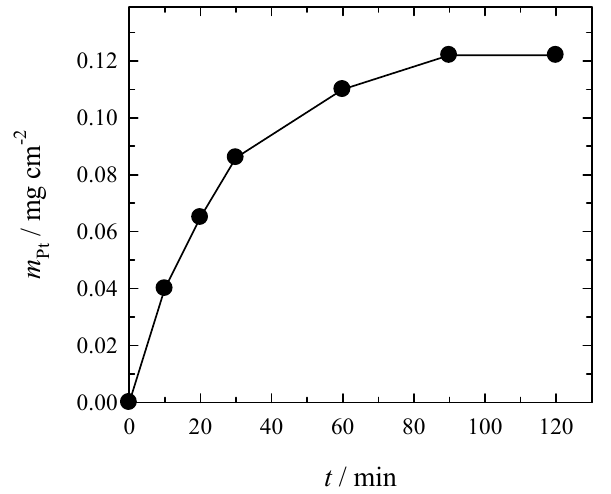
Figure 3. Dependence of deposited Pt mass on the roughed glass sheet on time under conditions with Ar bubbling. The solution composition is the same as in Figure 2.